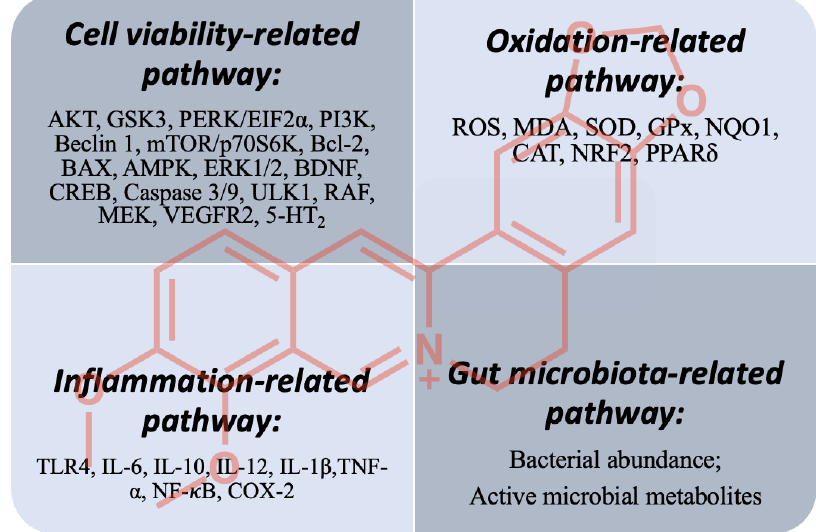
Figure 6. A summary of mechanisms of BBR on neurological disorders.